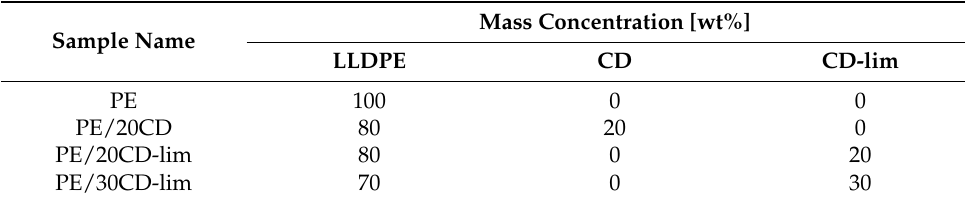
Table 2. Symbols and mass concentrations of